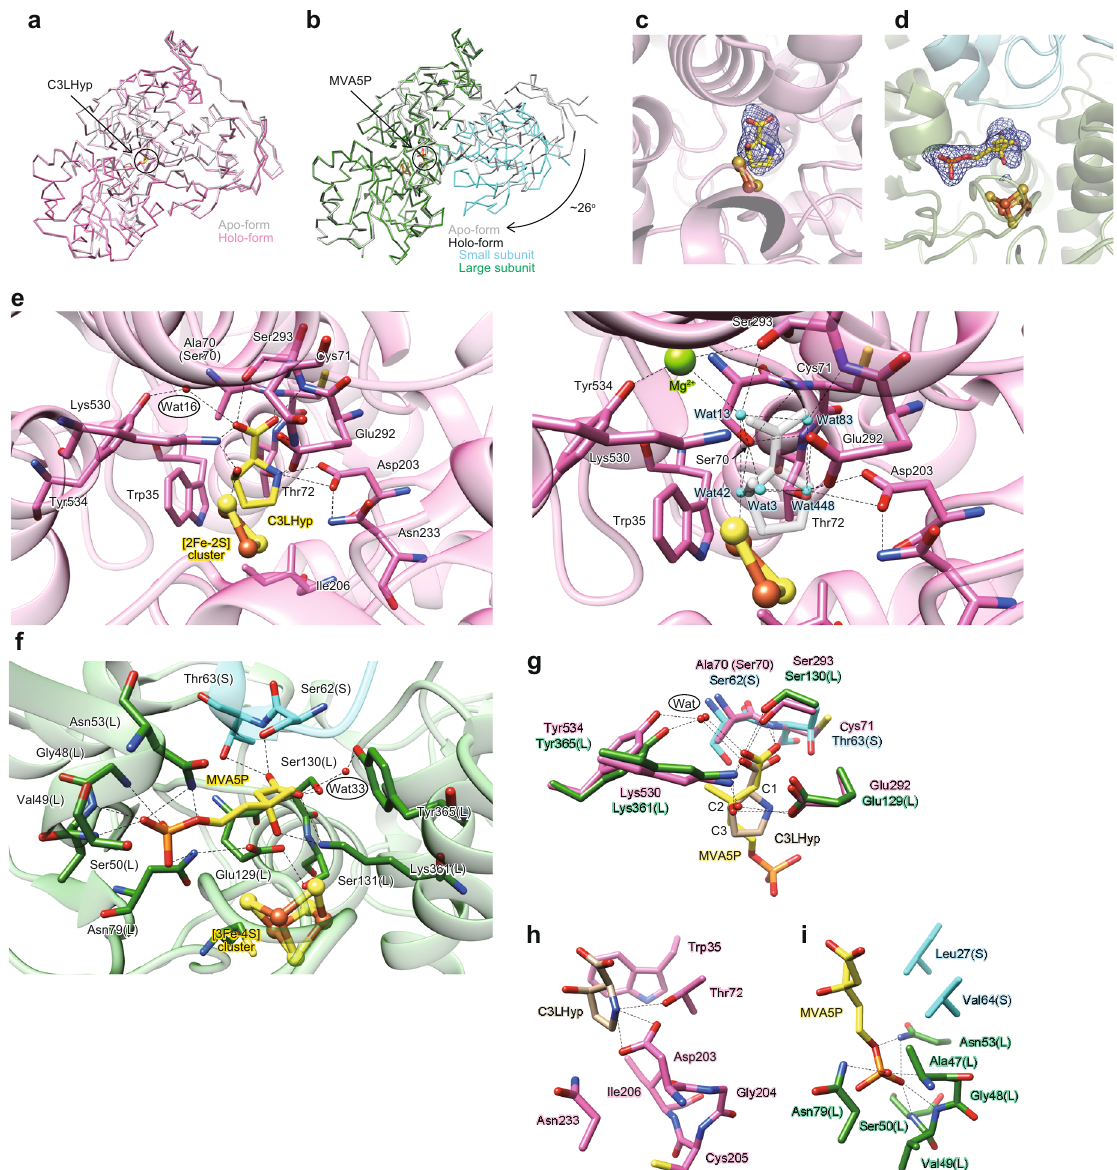
Fig. 6 Analysis of substrate-binding sites in AcnX. A C α trace of AtAcnX ( a ) and TkAcnX ( b ) showing similarities between the apo- and holo-forms. Bound C3LHyp and MVA5P are represented as a ball-and-stick model. In TkAcnX, the holo-form showed a more closed conformation than the apo-form by rigid-body subunit movement (~26°). Electron density maps of bound C3LHyp ( c ) and MVA5P ( d ). Simulated annealing mF o − DF c difference Fourier maps were calculated by omitting each molecule, and are shown as blue meshes countered at the 3.0 σ level. These angles were similar to those in e and f , respectively. Substrate recognition sites of AtAcnX ( e ) and TkAcnX ( f ). Active site residues are represented as stick models. The right panel of AtAcnX is the active site of the apo-form, in which C3LHyp (gray stick model) in the holo-form is superimposed. Five water molecules and one magnesium ion are represented as cyan and light-green balls, respectively. In TkAcnX, light-blue and green residues are derived from the small (S) and large subunits (L), respectively. The superposition of active sites that recognize common ( g ) and different structural backbones ( h , i ) between C3LHyp and